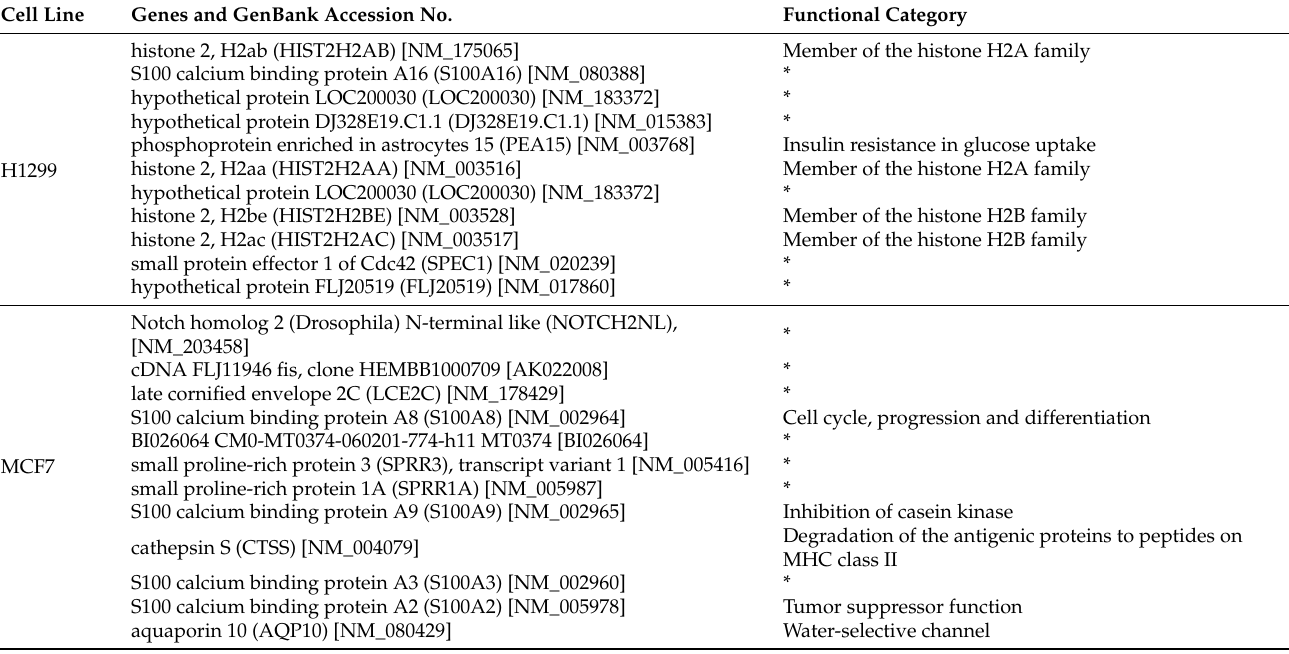
Table 2. Functional categories of up-regulated genes in chromosome 1q21. Cell Line Genes and GenBank Accession No.